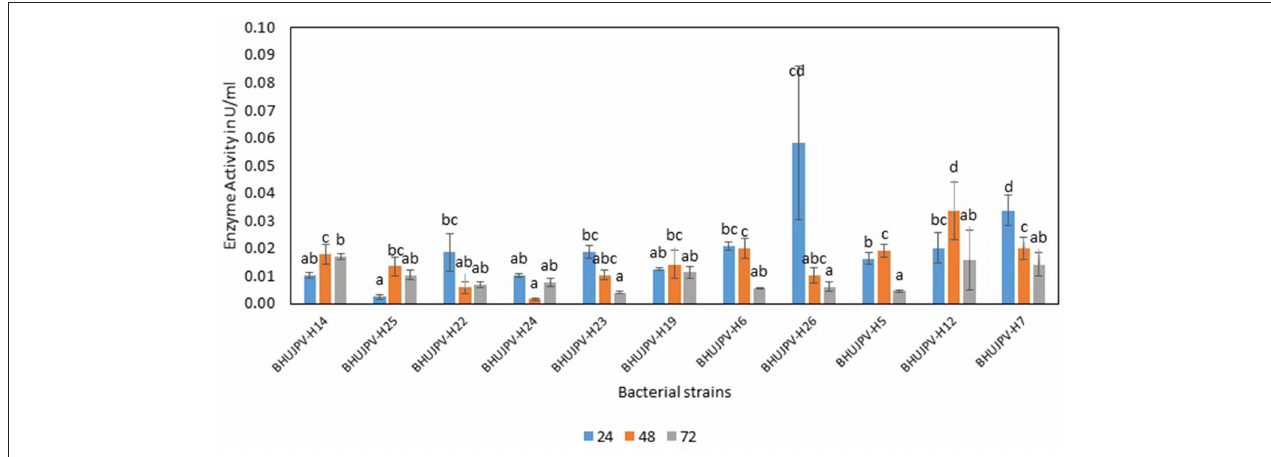
FIGURE 3 | Exoglucanase enzyme activity of the bacterial strains in the modified Mandel media at different time intervals. Values are the mean ± SE (standard error). Mean values in each bar with the same alphabet superscript(s) do not differ significantly, but different alphabet superscript is showed significantly different between each treatment by Duncan post hoc test ( p ≤ 0.05).